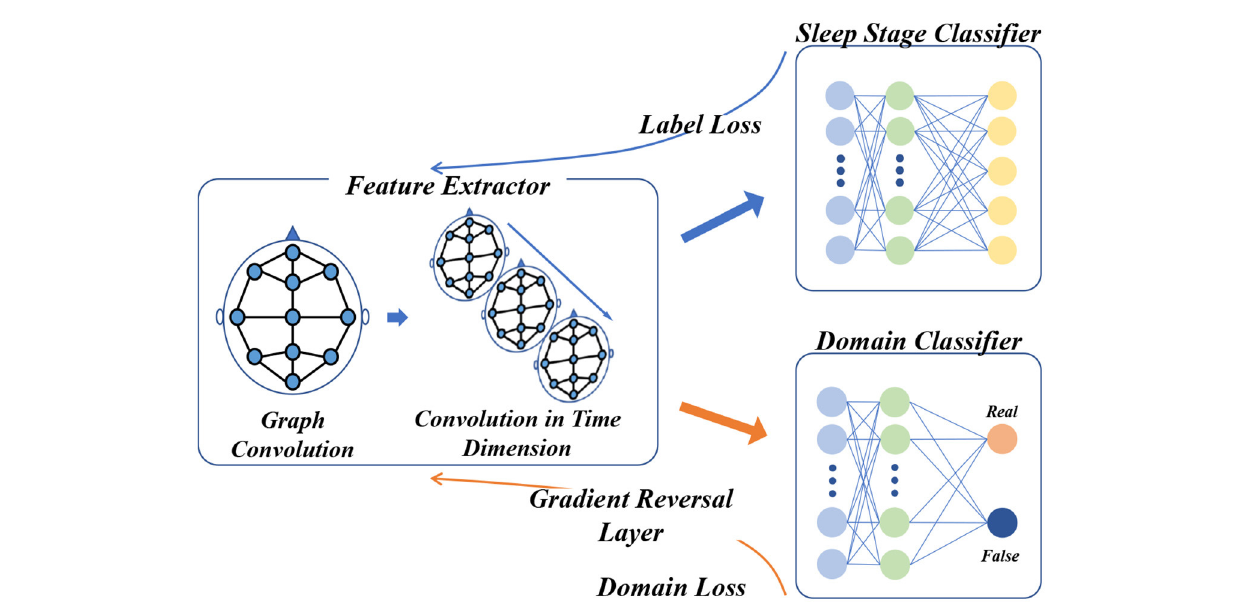
FIGURE4 Domain adversarial training framework for STDP-GCN. Following the blue arrow, the PSG signal is processed through the feature extractor to acquire the domain-invariant feature, which then proceeds to the sleep stage classifier for classification and computation of the label loss, before undergoing back-propagation. Along the yellow arrow, the domain-invariant feature is fed into the domain discriminator for domain classification and calculation of the domain loss, which then undergoes backpropagation through the Gradient Reverse Layer.